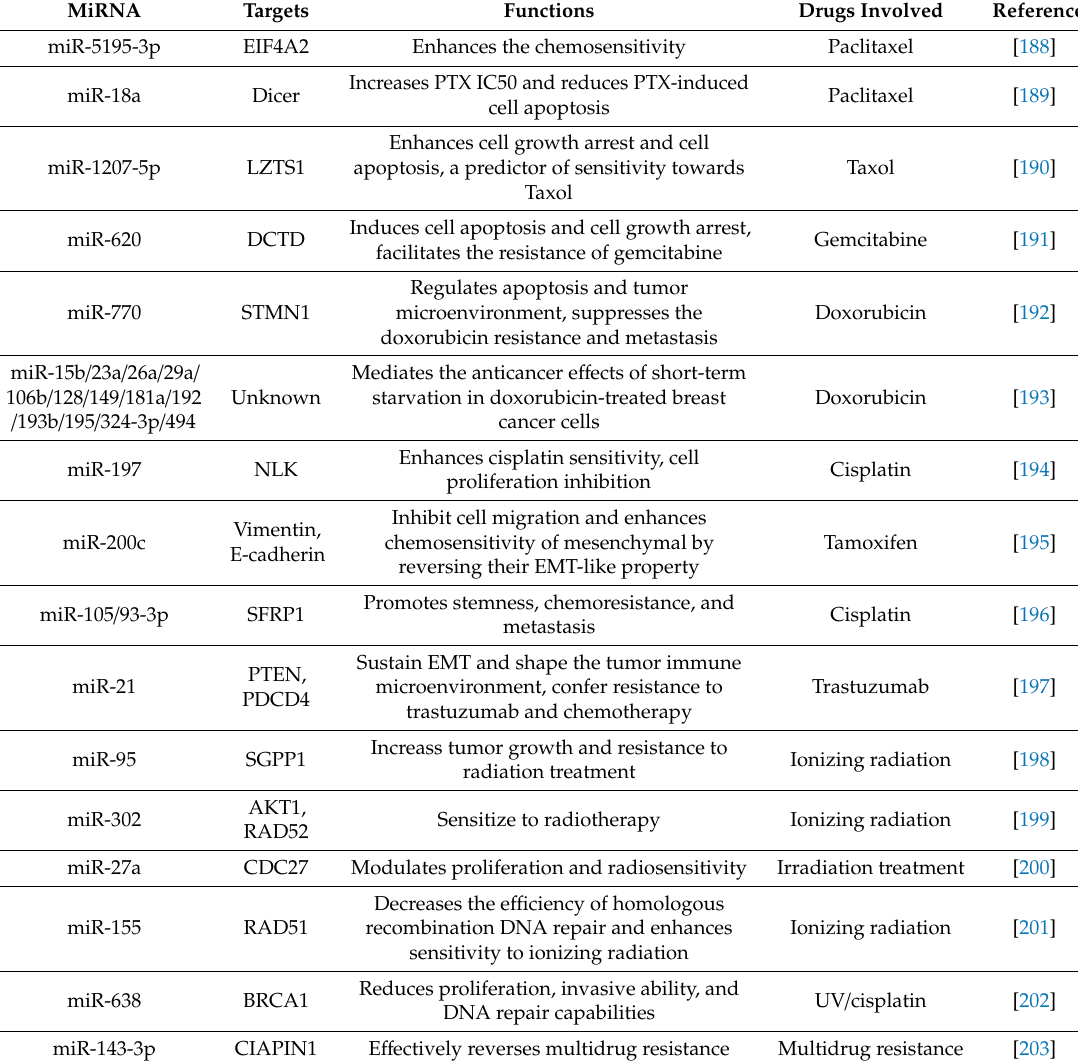
Table 9. MiRNAs associated with therapeutic resistance in